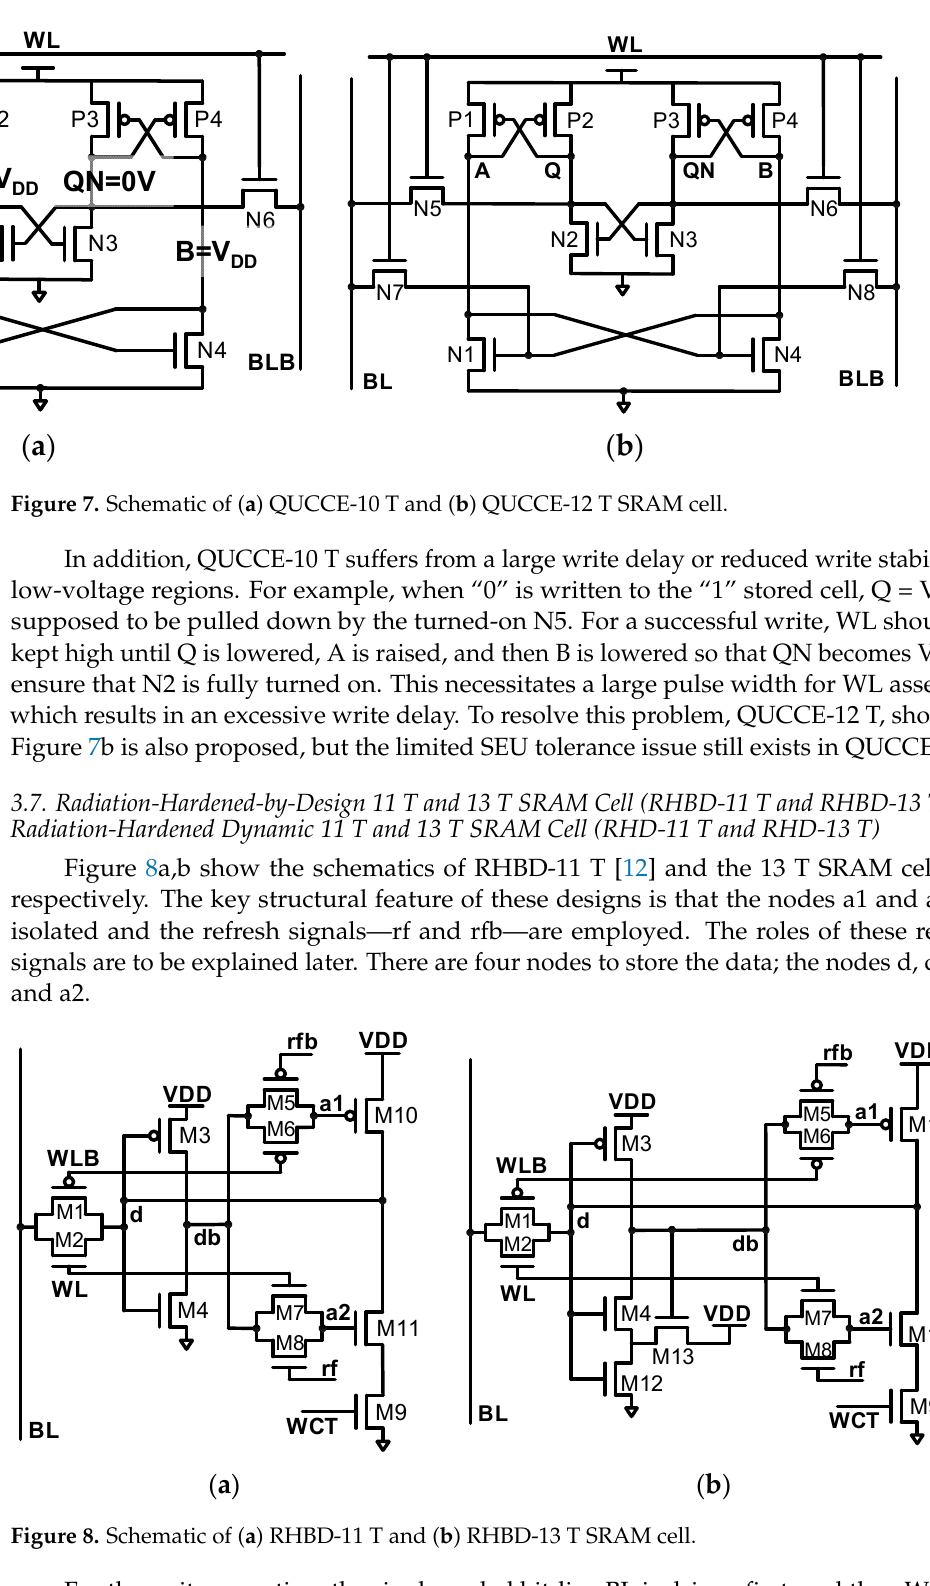
Figure 8. Schematic of ( a ) RHBD-11 T and ( b ) RHBD-13 T SRAM cell. For the write operation, the single-ended bit-line BL is driven first, and then WL and WLB become high and low, respectively, to connect the node d with BL. The refresh signals are only inserted for the refresh operation; thus, the nodes rf and rfb are low and high, respectively. For example, when the datum “0” is written, BL is low, so d is driven to